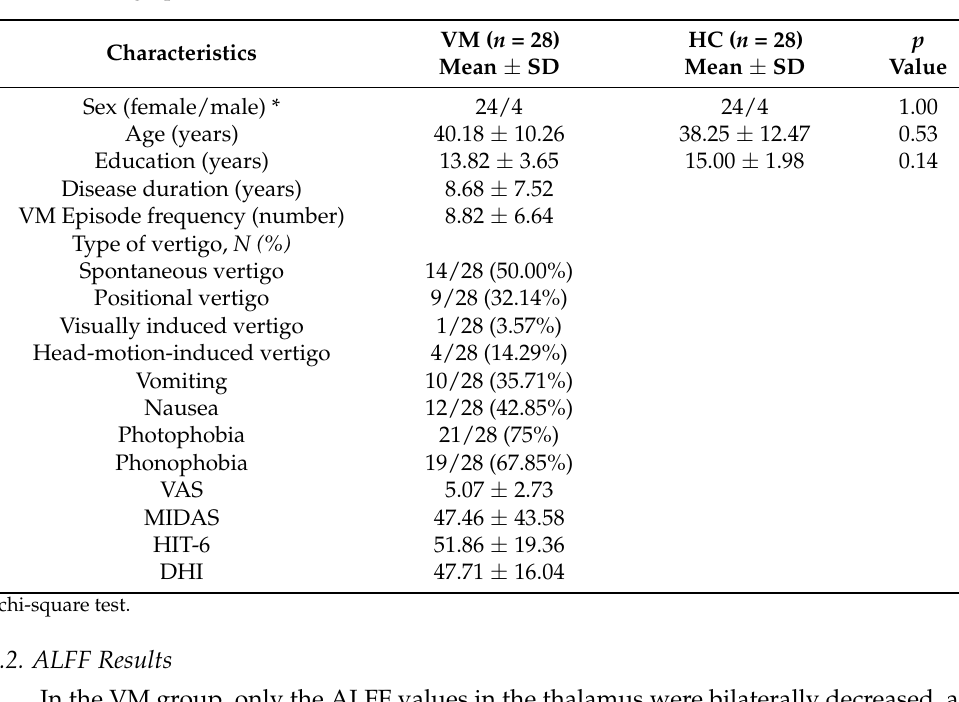
Table 1. Demographic and clinical characteristics.